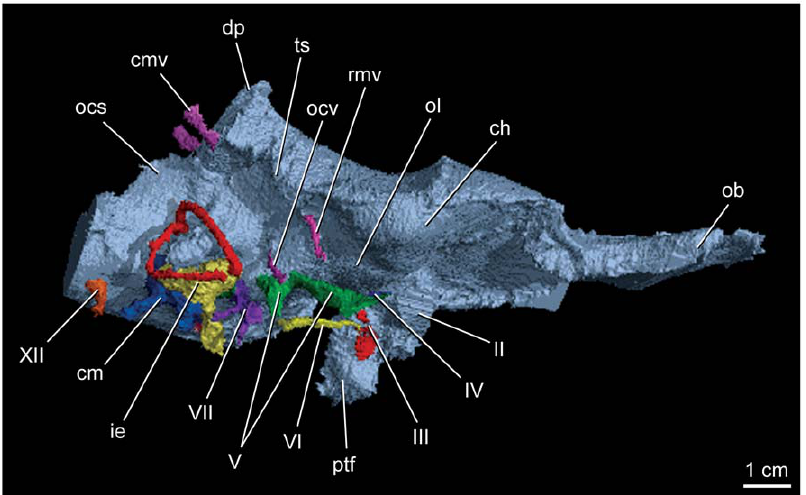
Figure 4. Right lateral view of labeled endocranial casts of Alioramusaltai (IGM 100/1844). These casts include the endocranial cavity, cranial nerve roots, selected vasculature, and inner ear. II, optic canal; III, oculomotor canal; IV, trochlear canal; V, trigeminal canals; VI, abducens canal; VII, facial canals; XII, hypoglossal canal; cm, cavum metoticum, includes lateral paths of glossopharyngeal and vagus nerves; cmv, caudal middle cerebral vein canal; ch, cerebral hemisphere; dp, dorsal peak (dural sinus); ie, inner ear; ob, olfactory bulb; ocs, occipital sinus; ocv, orbitocerebral vein; ol, optic lobe; ptf, pituitary fossa; rmv, rostral middle cerebral vein canal.